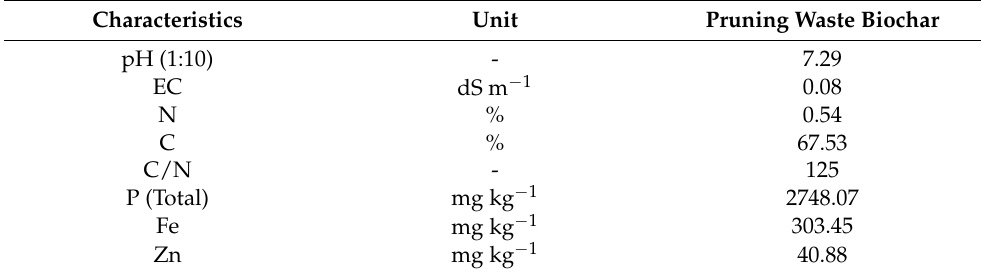
Figure 1. Schematic illustration of the preparation of biochar. Table 2. Characteristics of the pruning waste biochar.